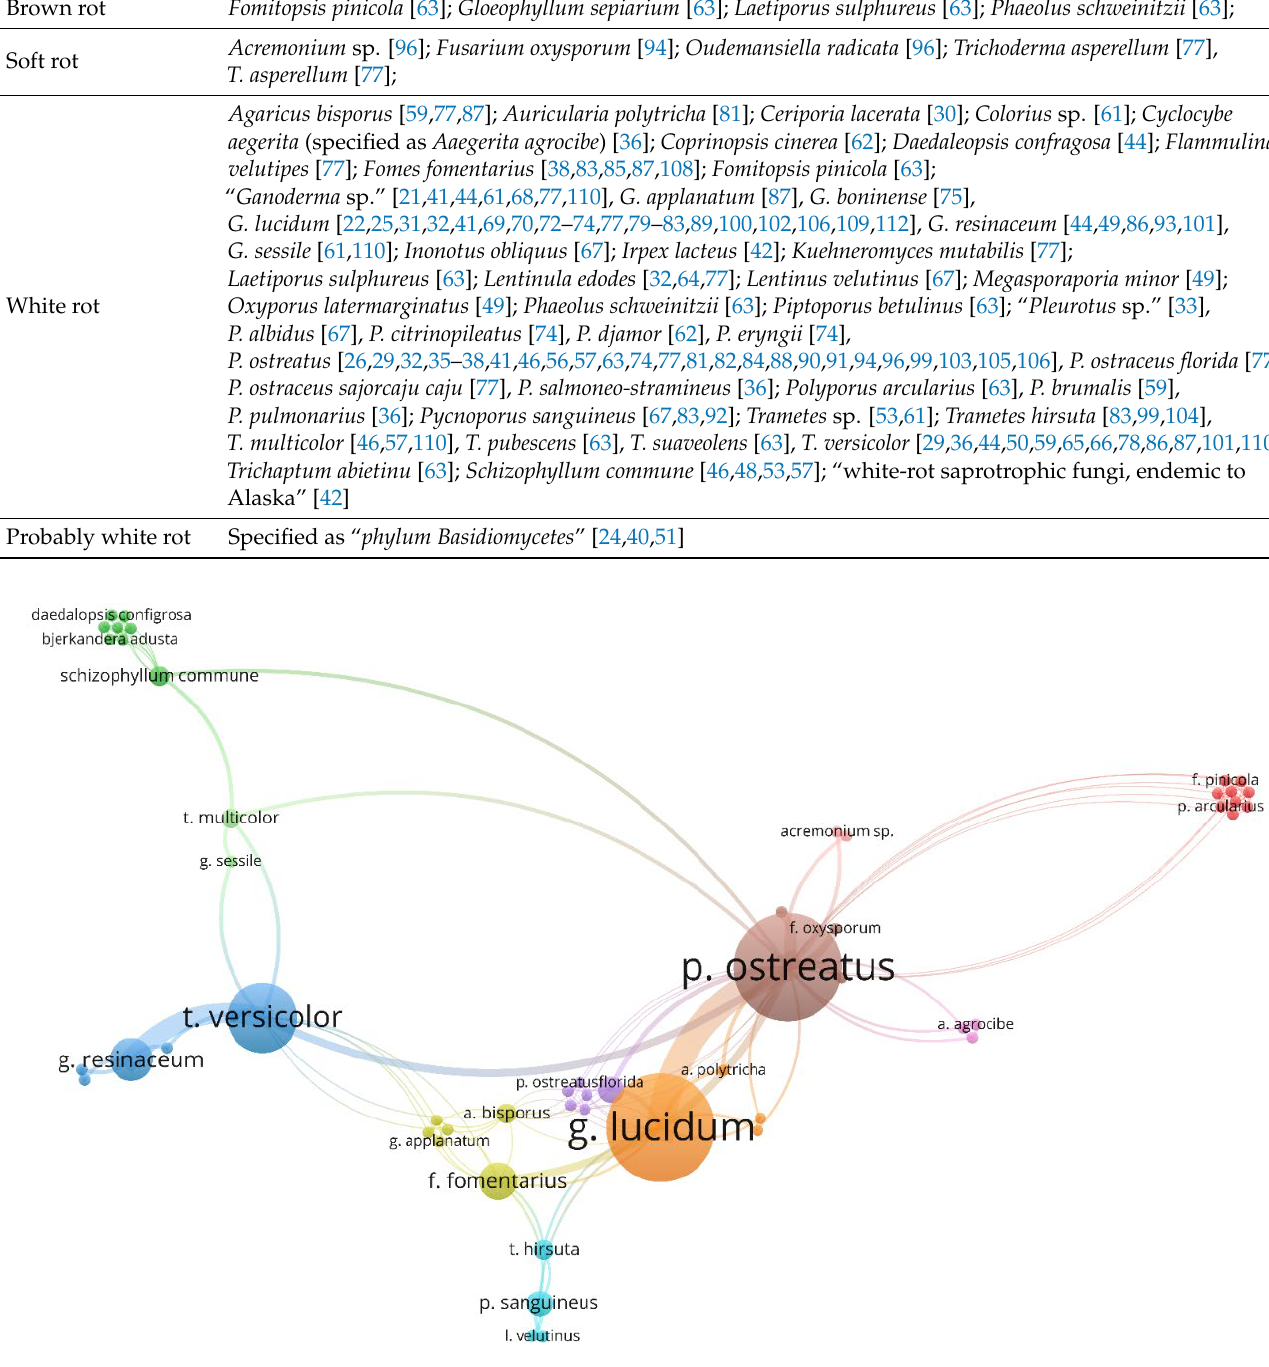
Figure 7. Fungus species in the scientific literature related to Mycelium-Based Composites.